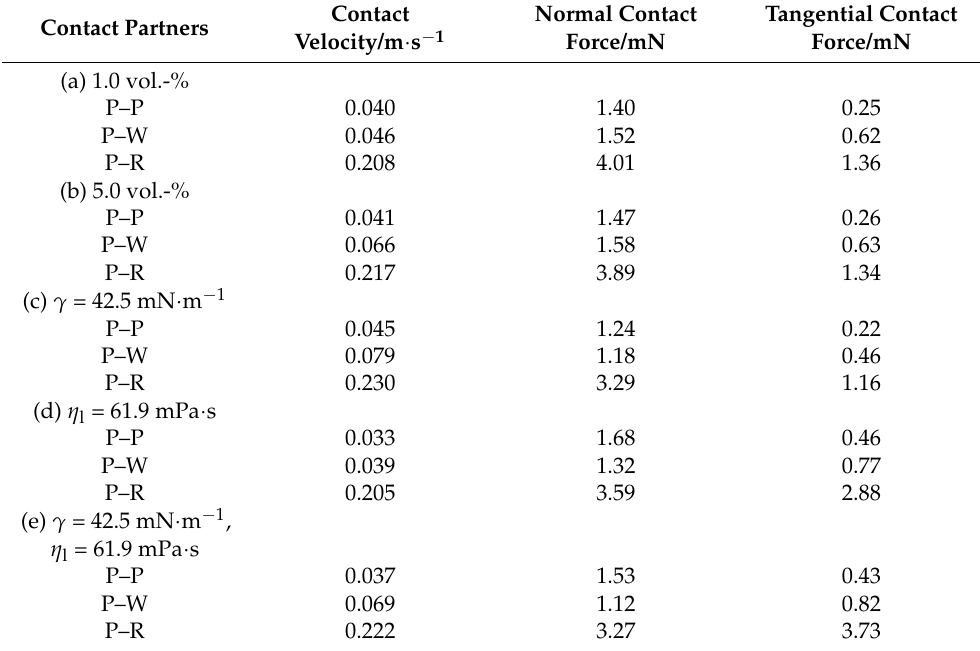
Table 6. Average contact velocities and forces for the five simulation cases in contacts between particles (P–P), particles with the cylindrical wall (P–W) and particles with rotor plate (P–R). Contact Normal Contact Tangential Contact Contact Partners Velocity/m · s − 1 Force/mN